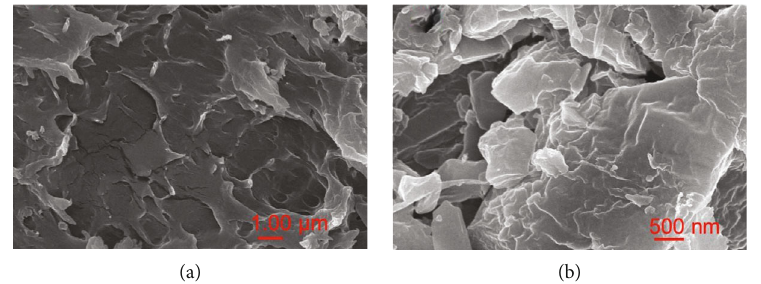
Figure 1: SEM images of hydrogel at various magni fi cations: (a) 1.00 μ m and (b) 500